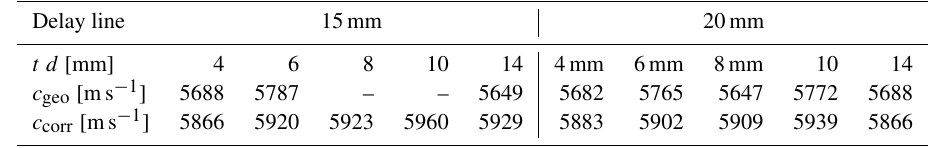
Table 4. Comparison of determined sound velocities with the attaching points y E , geo (from array geometry) and corrected y E , corr via sound field simulations.